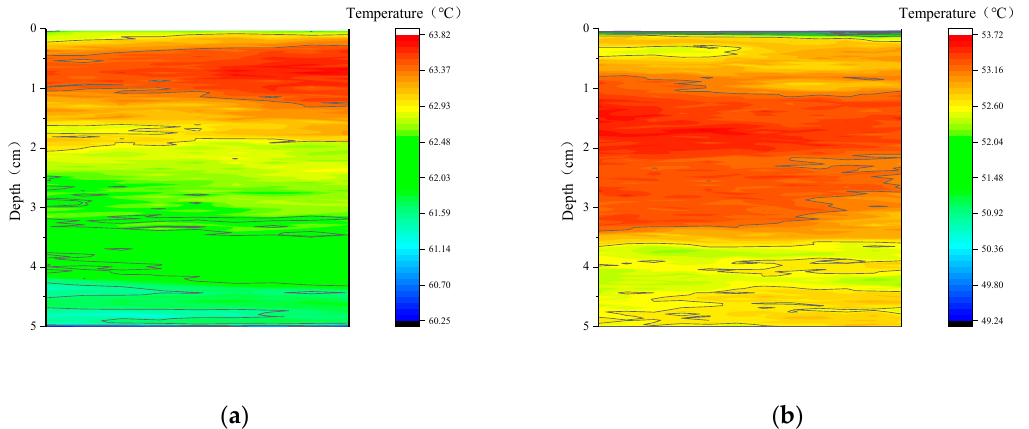
Figure 9. Effect of hollow glass microbeads on the cooling performance of coatings. ( a ) Process of heating to thermal equilibrium; ( b ) comparison of cooling effects .